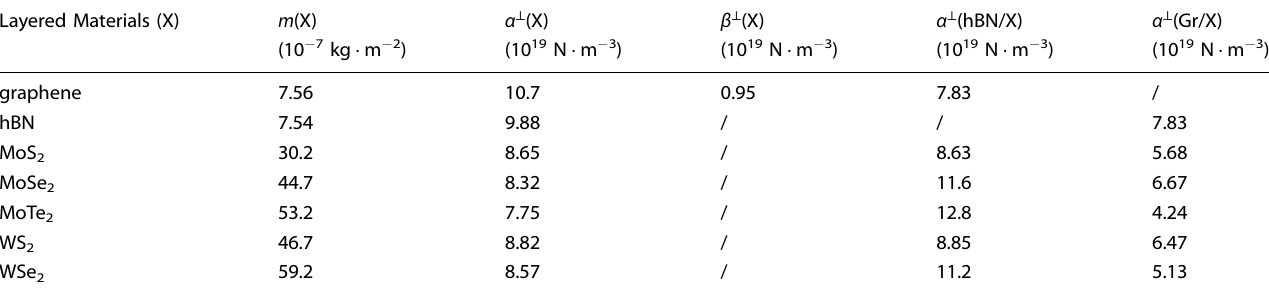
Table 1. LB force constants of layered materials and heterointerfaces. Layered Materials